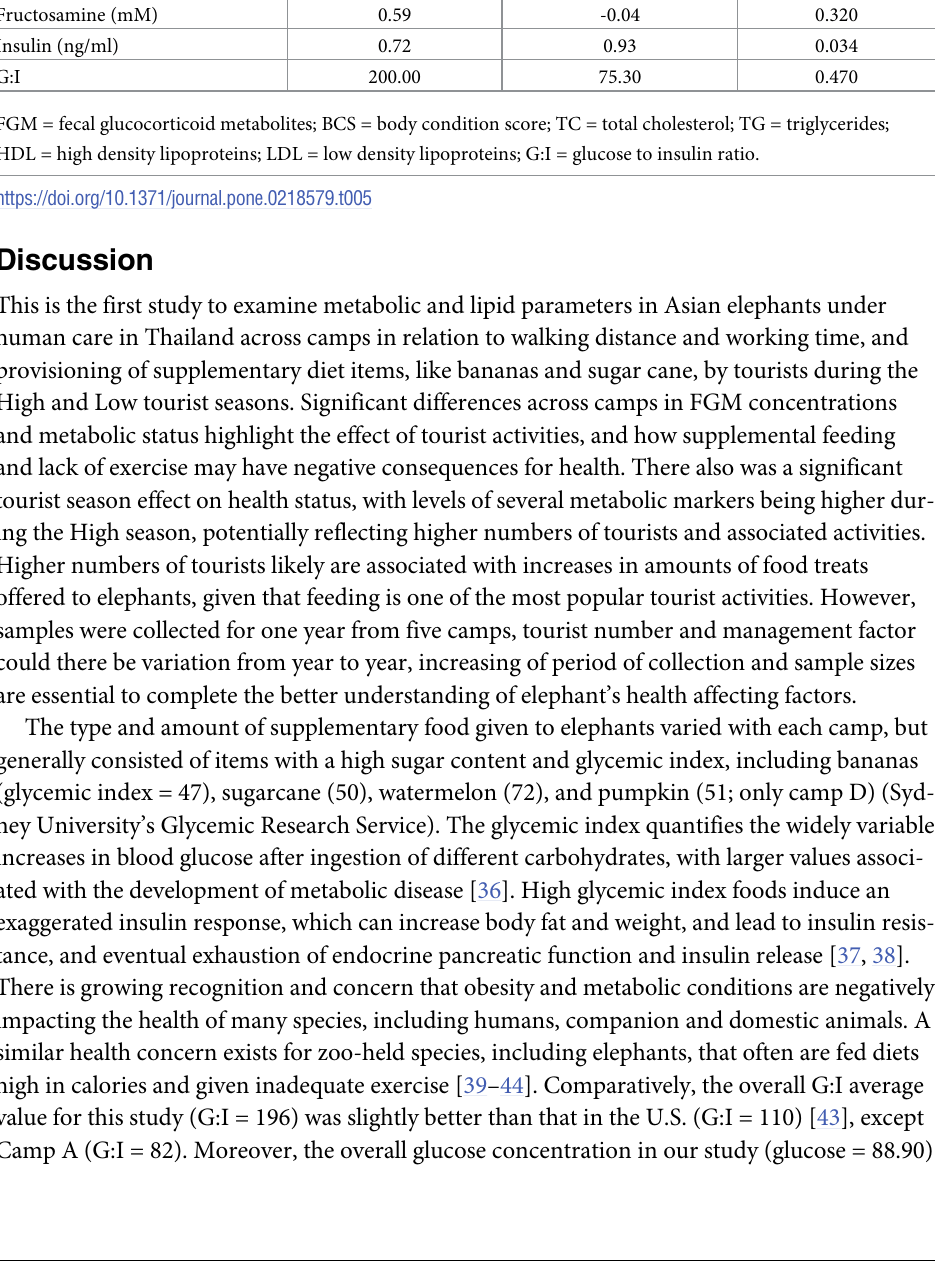
FGM = fecal glucocorticoid metabolites; BCS = body condition score; TC = total cholesterol; TG = triglycerides; HDL = high density lipoproteins; LDL = low density lipoproteins; G:I = glucose to insulin